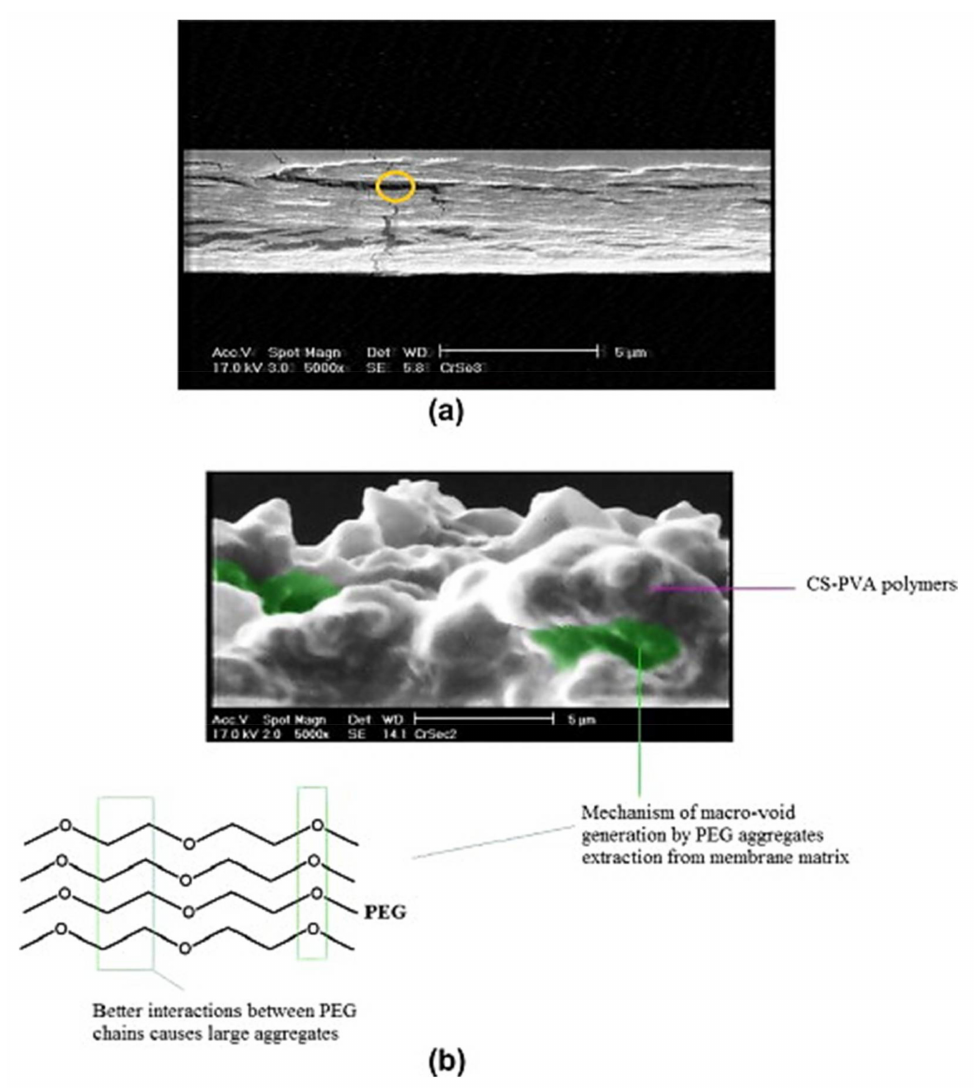
Figure 1. ( a ) MWCNT-NH 2 tails pulled out from the fractured matrix of CS/PVA/PEG/MWCNT- NH 2 membrane. ( b ) Macropores generated by extraction of PEG aggregates from CS/PVA polymeric matrix. Reprinted with permission from